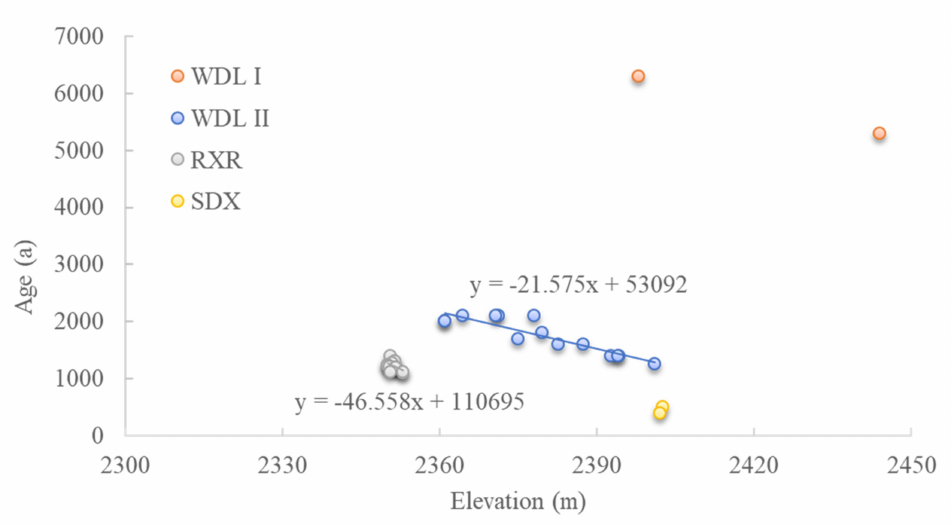
Figure 11. Grouping results of post-processing OSL dating data.